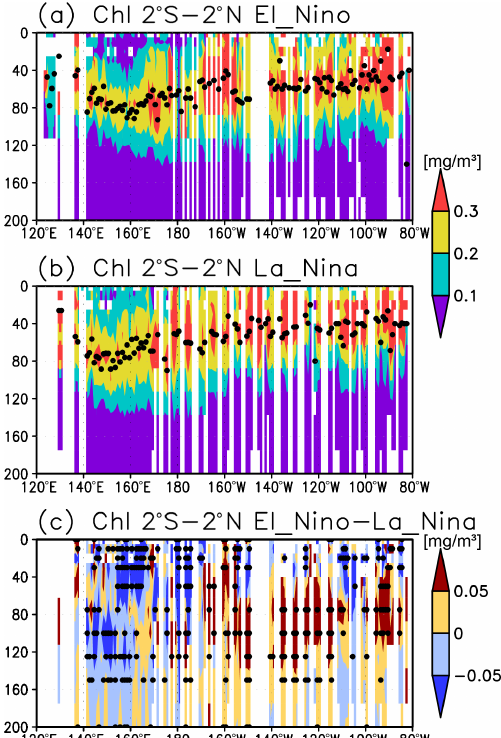
Figure 11. (a–c) Cross sections of the chlorophyll a (Chl a ) concen- trations in the equatorial Pacific (2 ◦ S to 2 ◦ N) during El Niño and La Niña and the difference between them. The black dots denote the depth of the Chl a maximum in (a) and (b) and the significant difference at 5% in (c) .